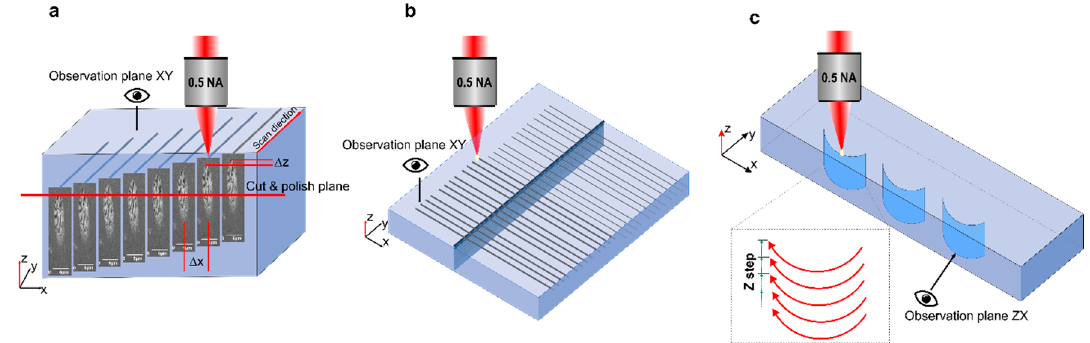
Figure 3. Schematic illustration of experiments: ( a ) recording and polishing of the lines written with double pulses for nanogratings observation by scanning electron microscope (SEM); ( b ) the line writing procedures for the investigation of the double-pulse influence on the chemical etching rate; ( c ) recording of the vertical bow-like structures for the investigation of directional etching